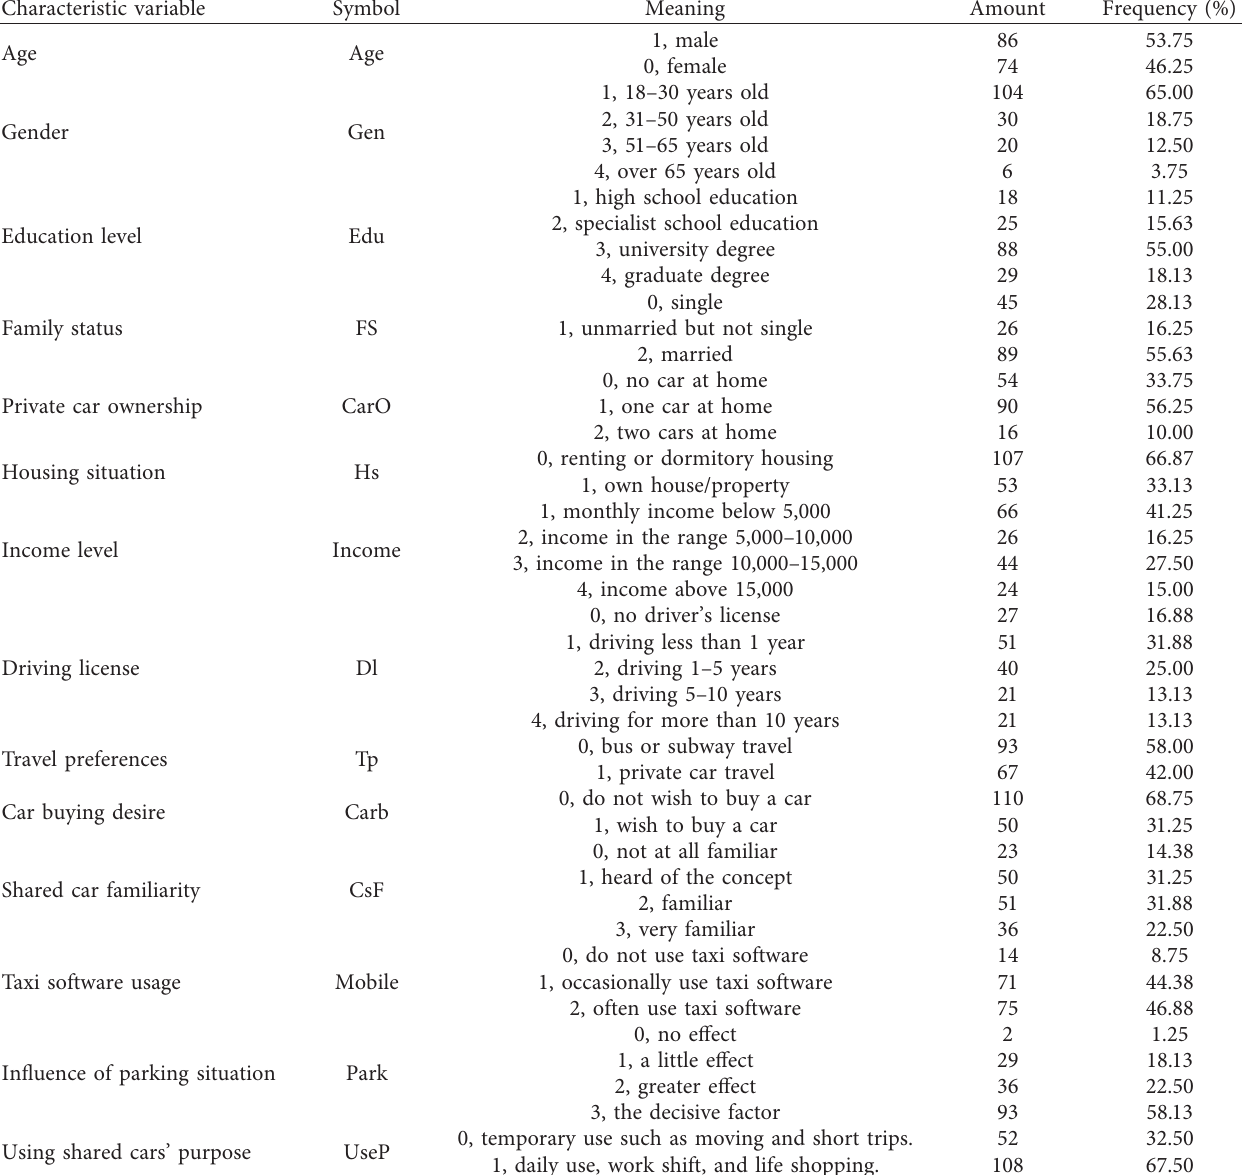
Table 3: Categorical variable coding table.